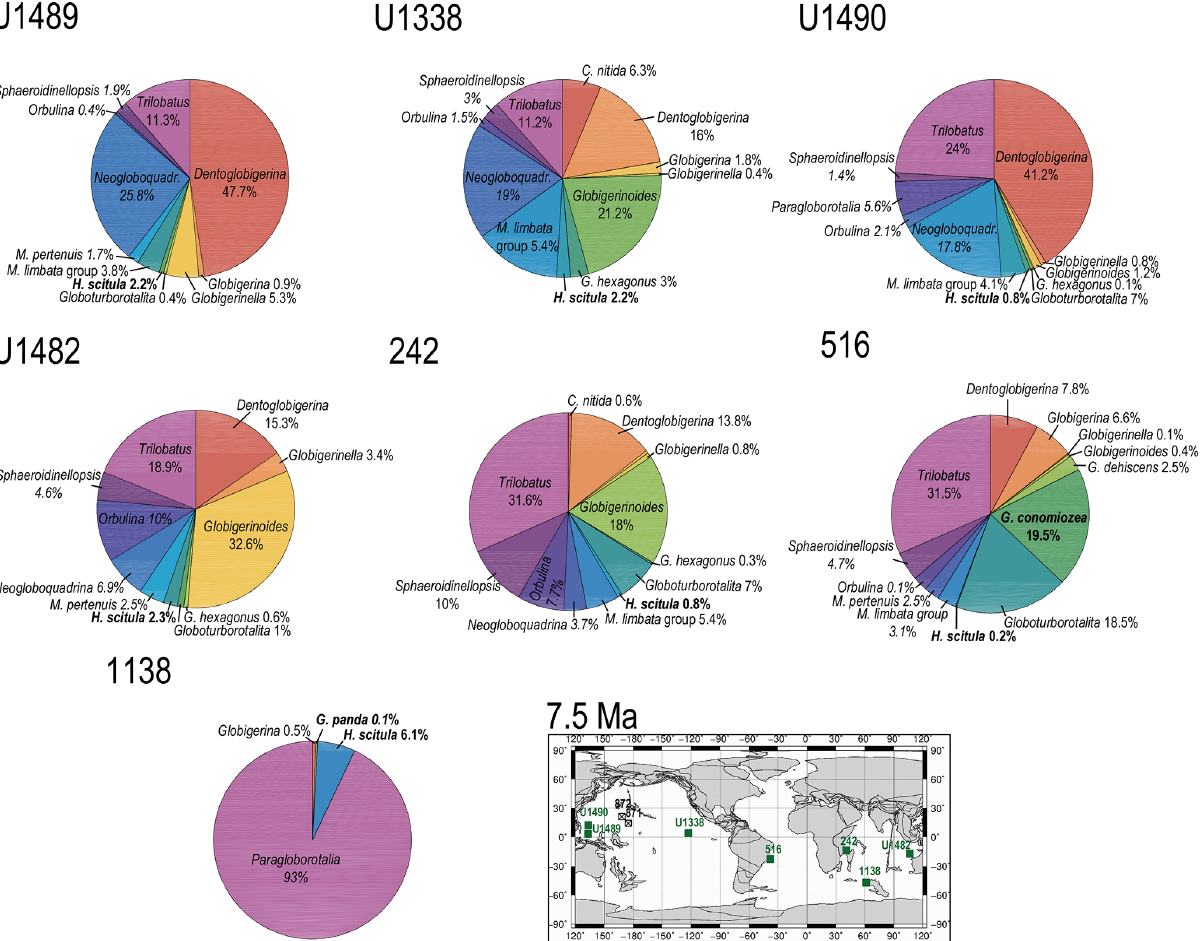
Figure 8. Abundance and biogeography of planktonic foraminiferal species at 7.5Ma. In the pie charts, twilight zone planktonic foraminiferal species are in bold. Sites where twilight zone planktonic foraminifera were found are highlighted in green on the maps. The crossed square symbols in the maps indicate that the time interval of interest was not recovered for a given site. Continental configuration follows the Ocean Drilling Stratigraphic Network (GEOMAR; Kiel,